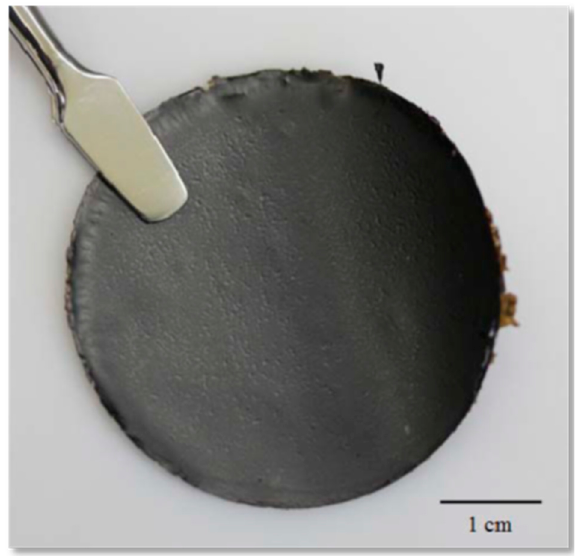
Figure 15. Photograph of a 12- µ m-thick standalone GO laminate prepared by vacuum filtration of GO nanoplatelets suspension in DI water. Reproduced from [75], with permission from Elsevier, 2014.